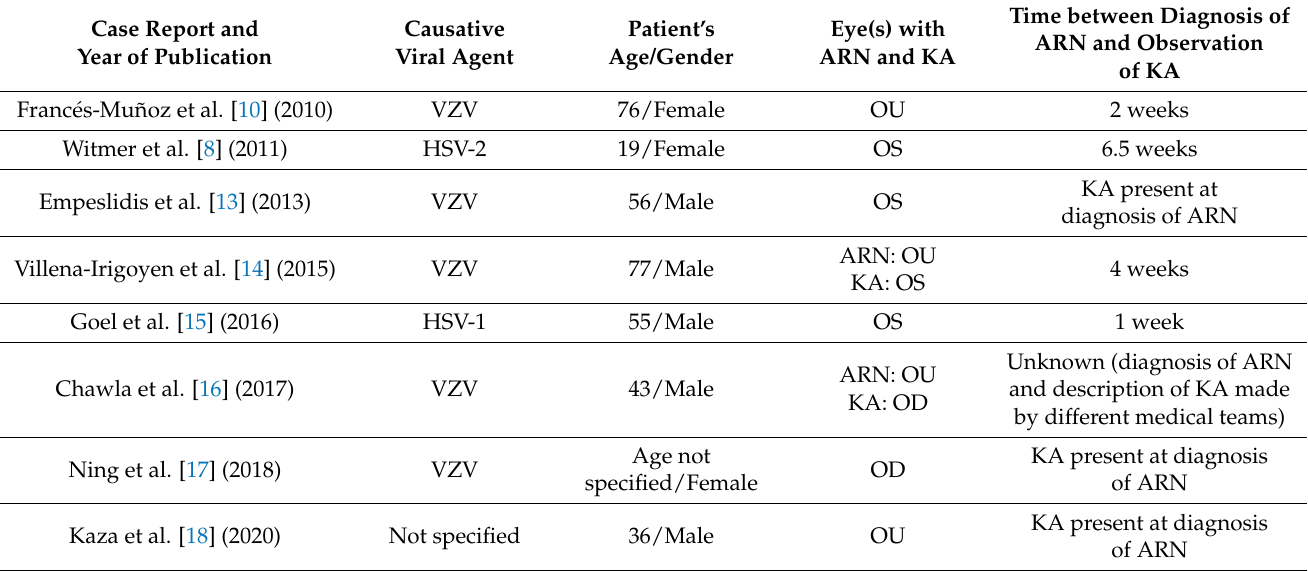
Table 2. Presentation of previous case reports of Kyrieleis arteriolitis in acute retinal